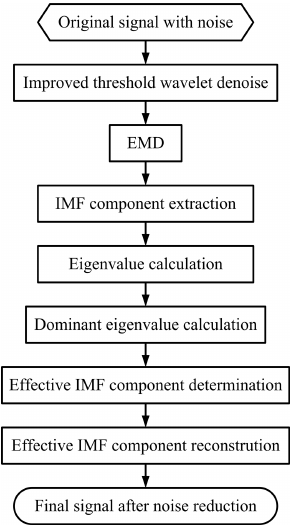
Figure 5. Noise reduction flow chart of combined method of improved wavelet and EMD.